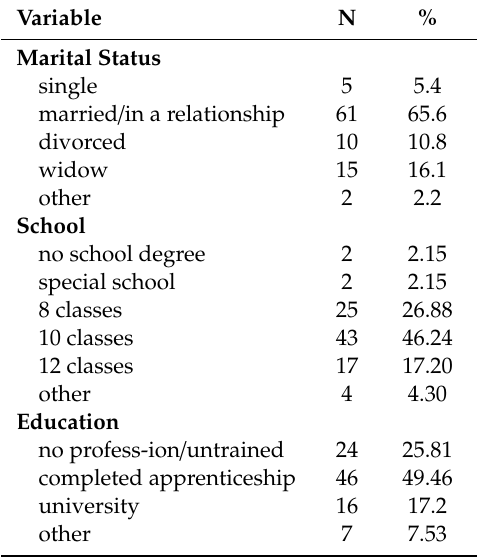
Table 1. Sociodemographic description of the